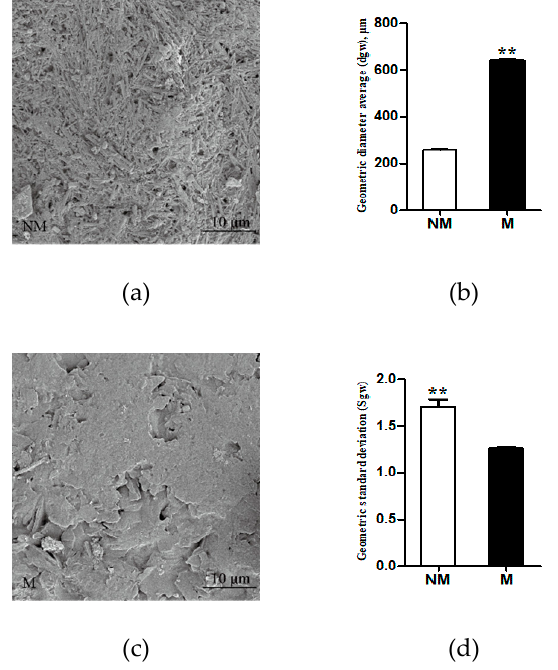
Figure 1. ( a ) The physical characteristics of non-microencapsulated vitamin form Figure 1. (a) The physical characteristics of non-microencapsulated vitamin form high-resolution scanning electron microscopy. (b) The geometric diameter average (dgw) of NM (non-